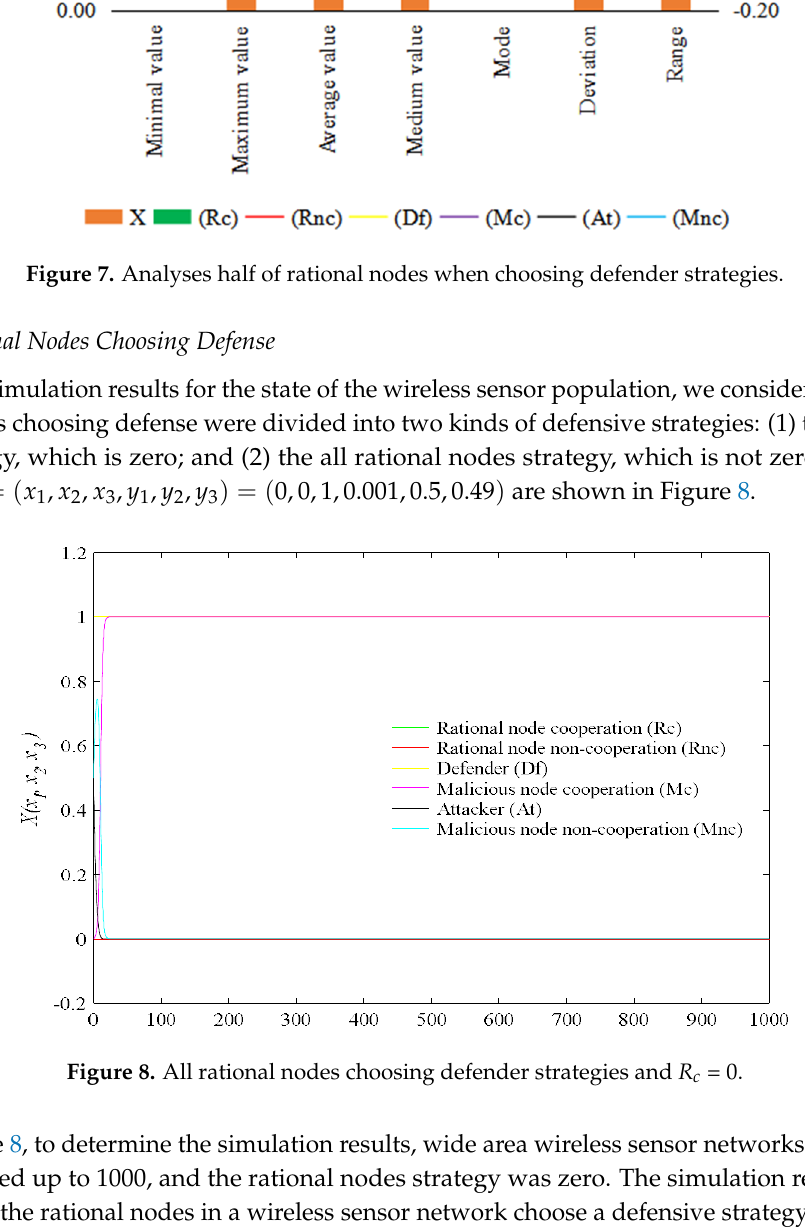
Figure 8. All rational nodes choosing defender strategies and Rc = 0.